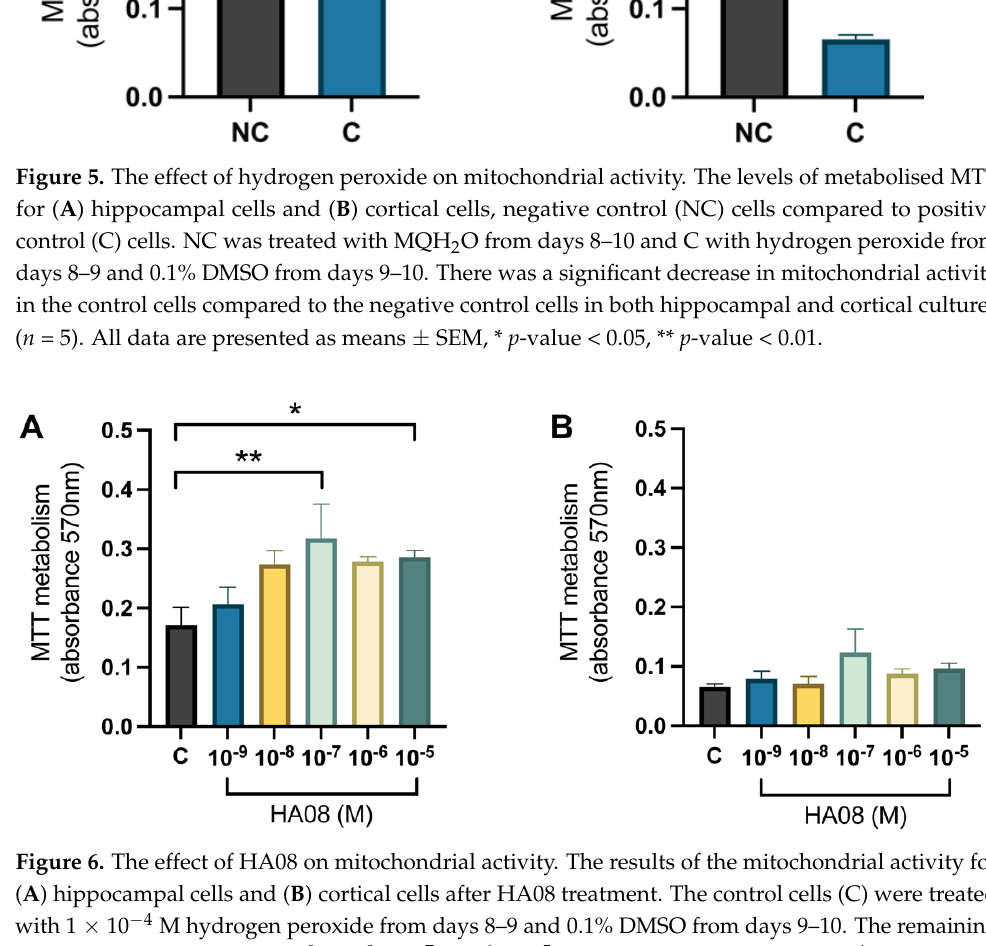
Figure 5. The effect of hydrogen peroxide on mitochondrial activity. The levels of metabolised MTT for ( A ) hippocampal cells and ( B ) cortical cells, negative control (NC) cells compared to positive control (C) cells. NC was treated with MQH 2 O from days 8–10 and C with hydrogen peroxide from days 8–9 and 0.1% DMSO from days 9–10. There was a significant decrease in mitochondrial activity ( n = 5). All data are presented as means ± SEM, * p -value < 0.05, ** p -value < 0.01.